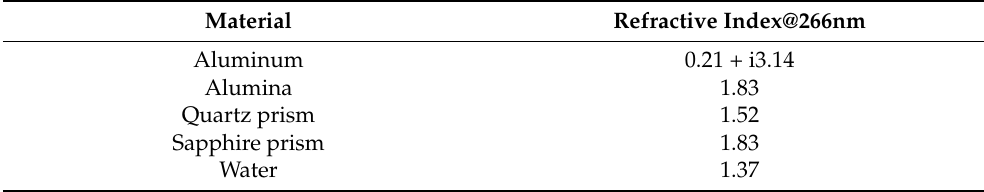
Figure 1. Schematic diagram of living yeast cell observation using deep-UV SPR. Table 1. Refractive indices at 266 nm wavelength used in the Kretschmann